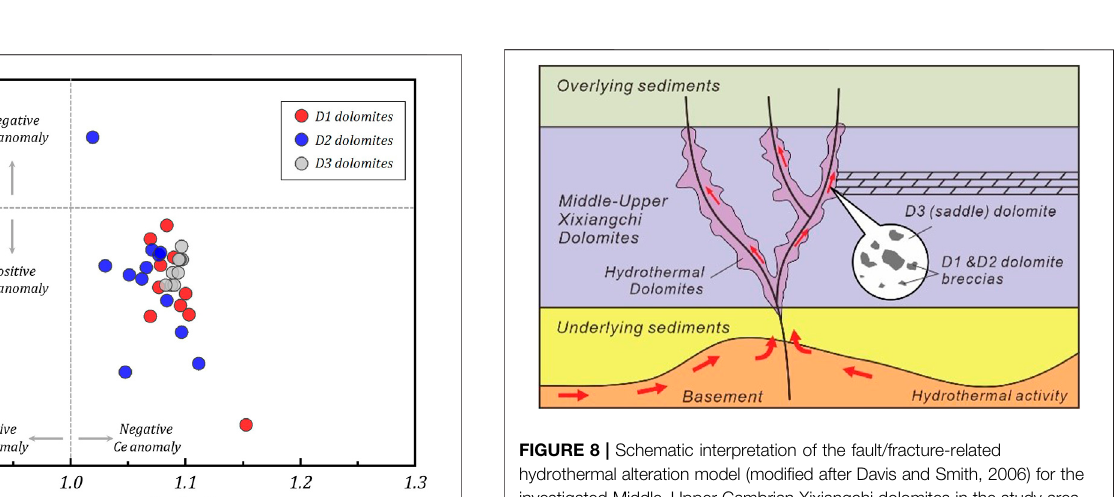
FIGURE6| PatternofmeanPAAS-normalizedREE concentrationsoftheinvestigatedMiddle – Upper Cambrian Xixiangchidolomites (REEcompositionofmodern seawater from Alibo and Nozaki, 1999; Kawabe et al., 1998). It should be noted that the REE compositions of modern seawater are multiplied by 10 6 times when normalized.